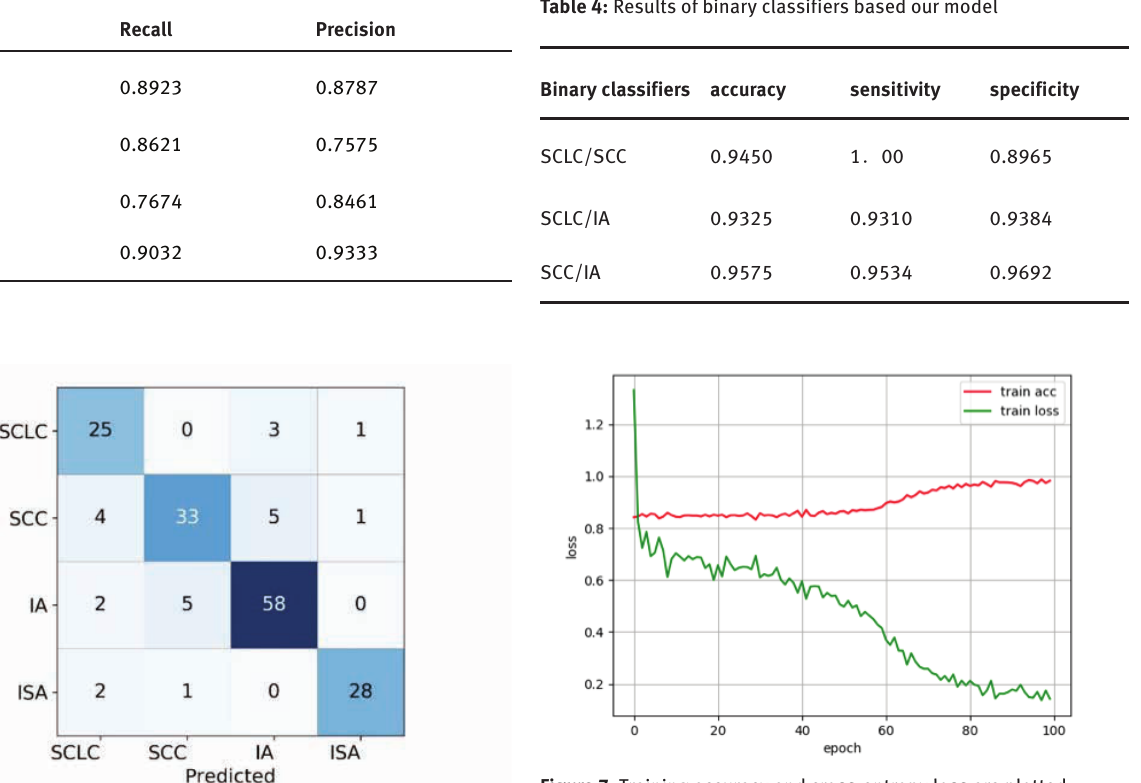
Figure 7: Training accuracy and cross-entropy loss are plotted against the training epoch. Plots were normalized with a smoothing factor of 0.5 to clearly visualize trends.